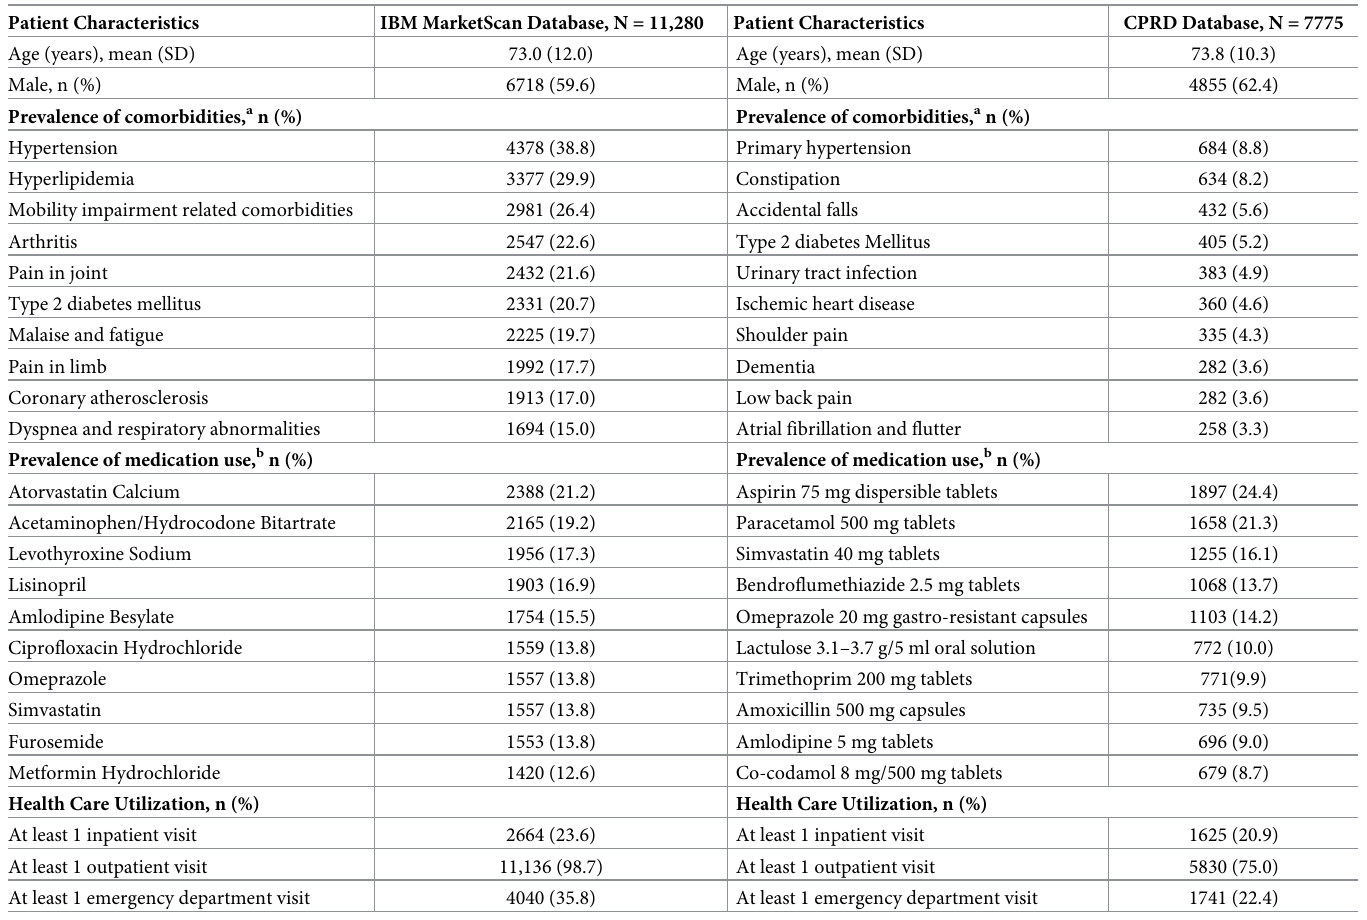
Table 1. Demographics and baseline characteristics of the study